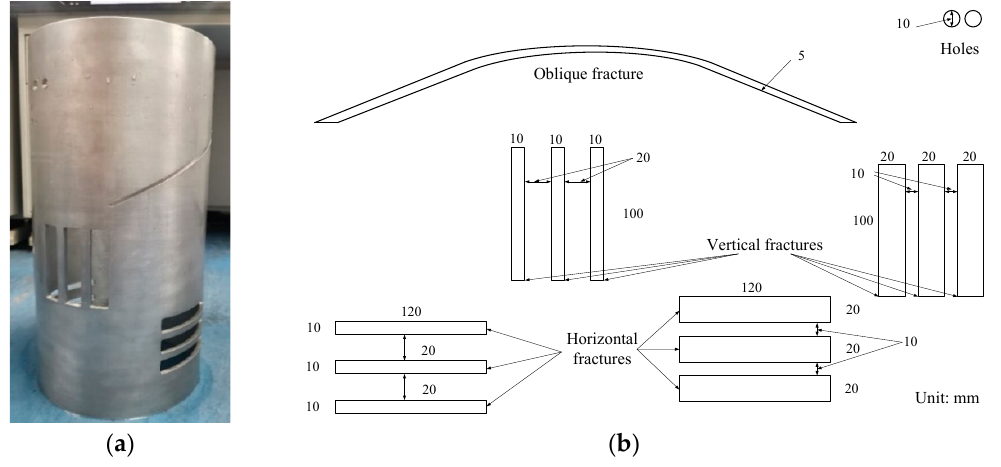
Figure 8. Fracture simulated borehole and its unfolded drawing. ( a ) Physical diagram of the simulated borehole and ( b ) Unfolded drawing of the borehole wall.